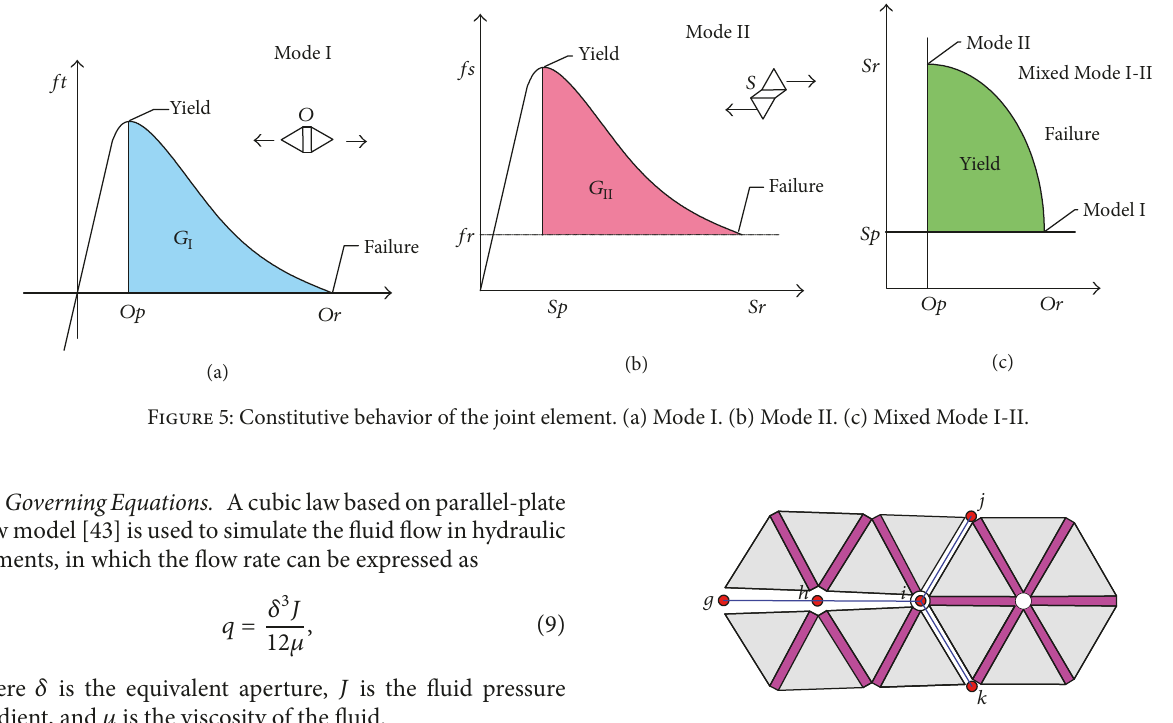
Figure 6: Fluid flow in the hydraulic fracture network and the influence domain of node 𝑖